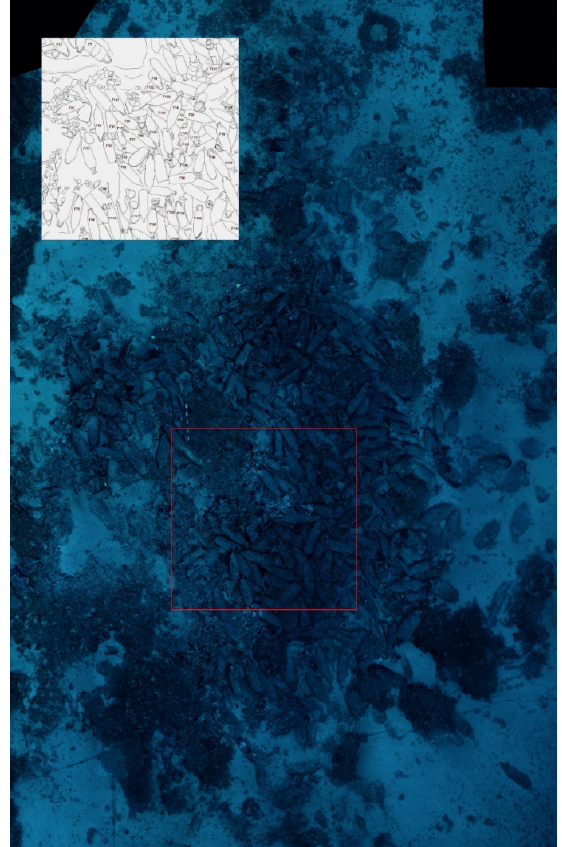
Figure 5: Orthophotomosaic and detail of the 2D drawing of wreck No.16, © H.I.M.A., E. Diamanti